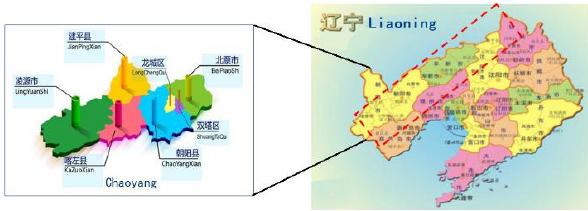
Figure 1. schematic diagram of study